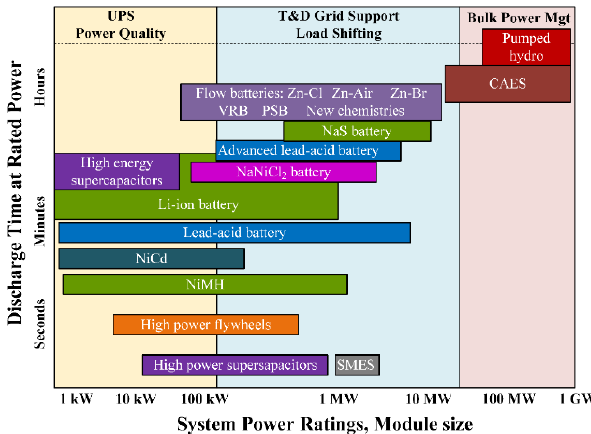
Figure 79. Globally installed energy storage capacity of different types of ESSs [19].